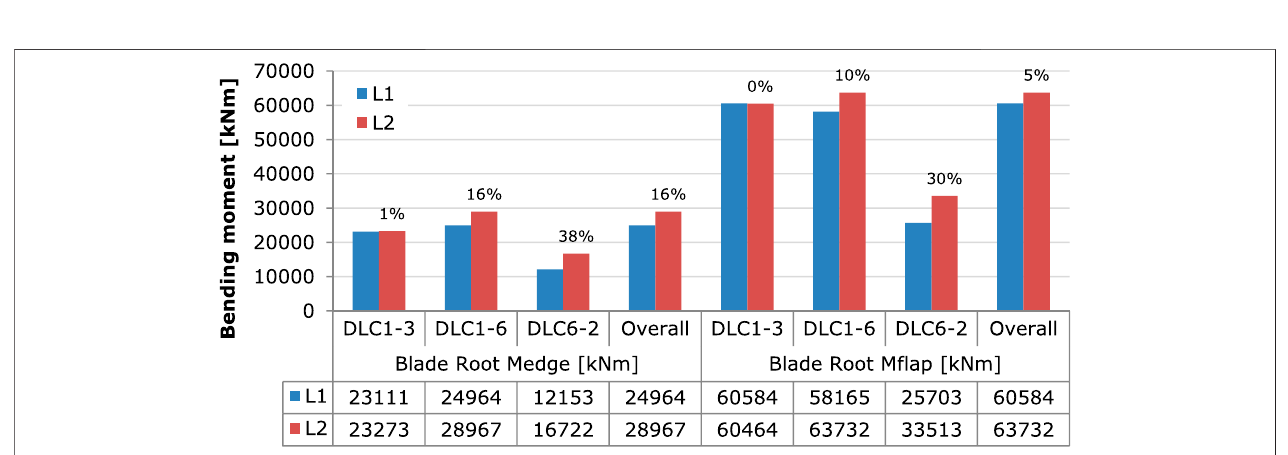
FIGURE 12 | Comparison of ultimate blade root edgewise (Medge) and fl apwise (M fl ap) moments for the DLCs performed at L1 and L2. The relative percentage difference with respect to L1 is also provided above the bars.